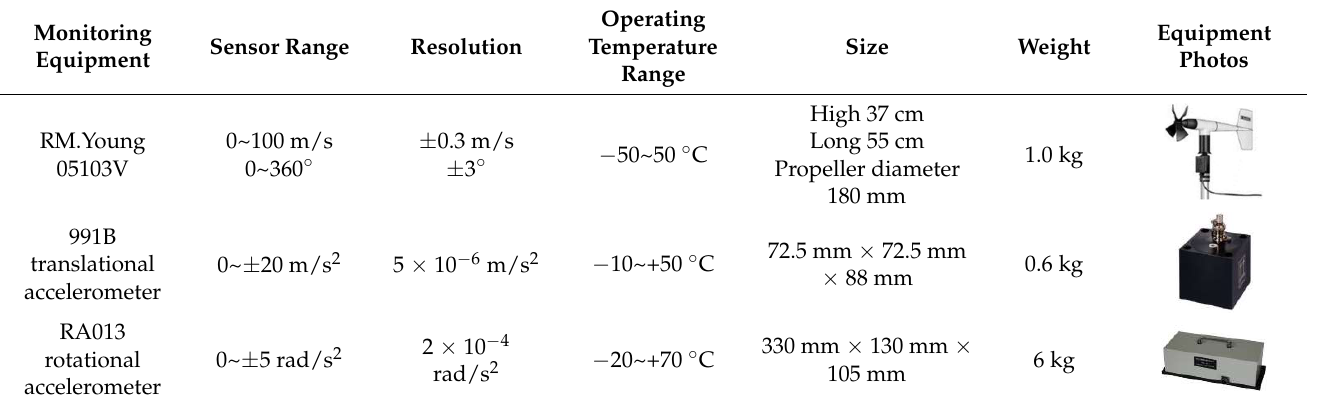
( b ) Figure 5. Time history of acceleration response on 32th floor during Typhoon Sarika. ( a ) 32nd floor along x axis; ( b ) 32nd floor along y axis.